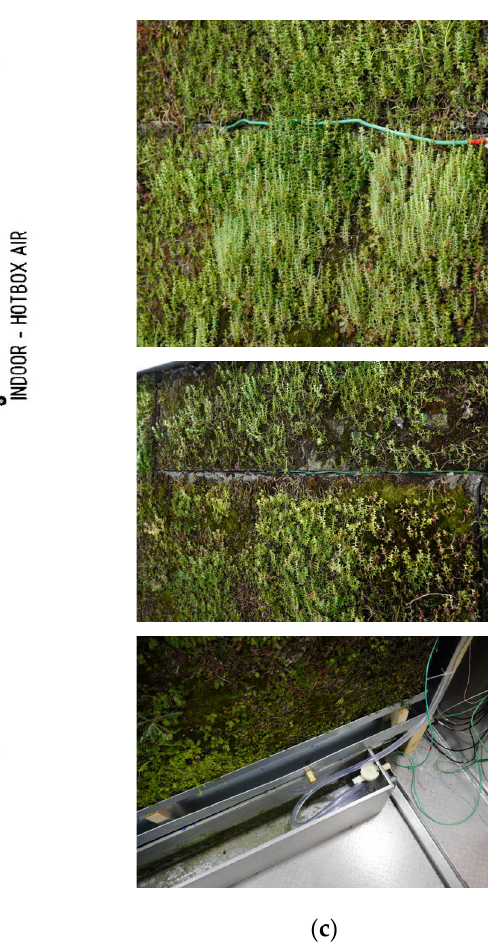
Figure 2. View of the outer skin before ( a ) and after the measurement ( b ). Despite heavy watering at the end, the vegetation was very dry, which was caused by the simulated solar radiation (simu- lated steady-state test, which is not presented in this paper) and water pump failure.